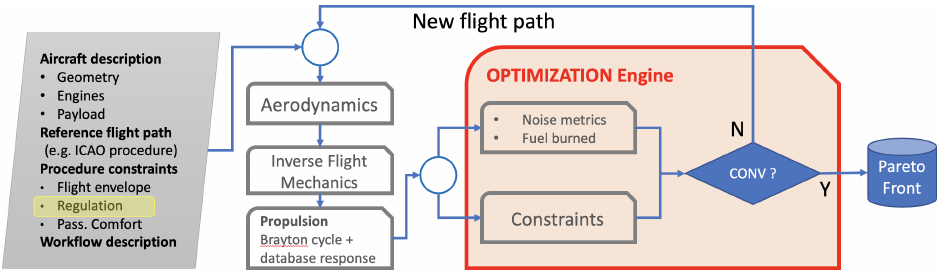
Figure A2. FRIDA workflow for the procedure optimisation. Starting from the throttle percentage, the rotational speeds N 1 and N 2 of